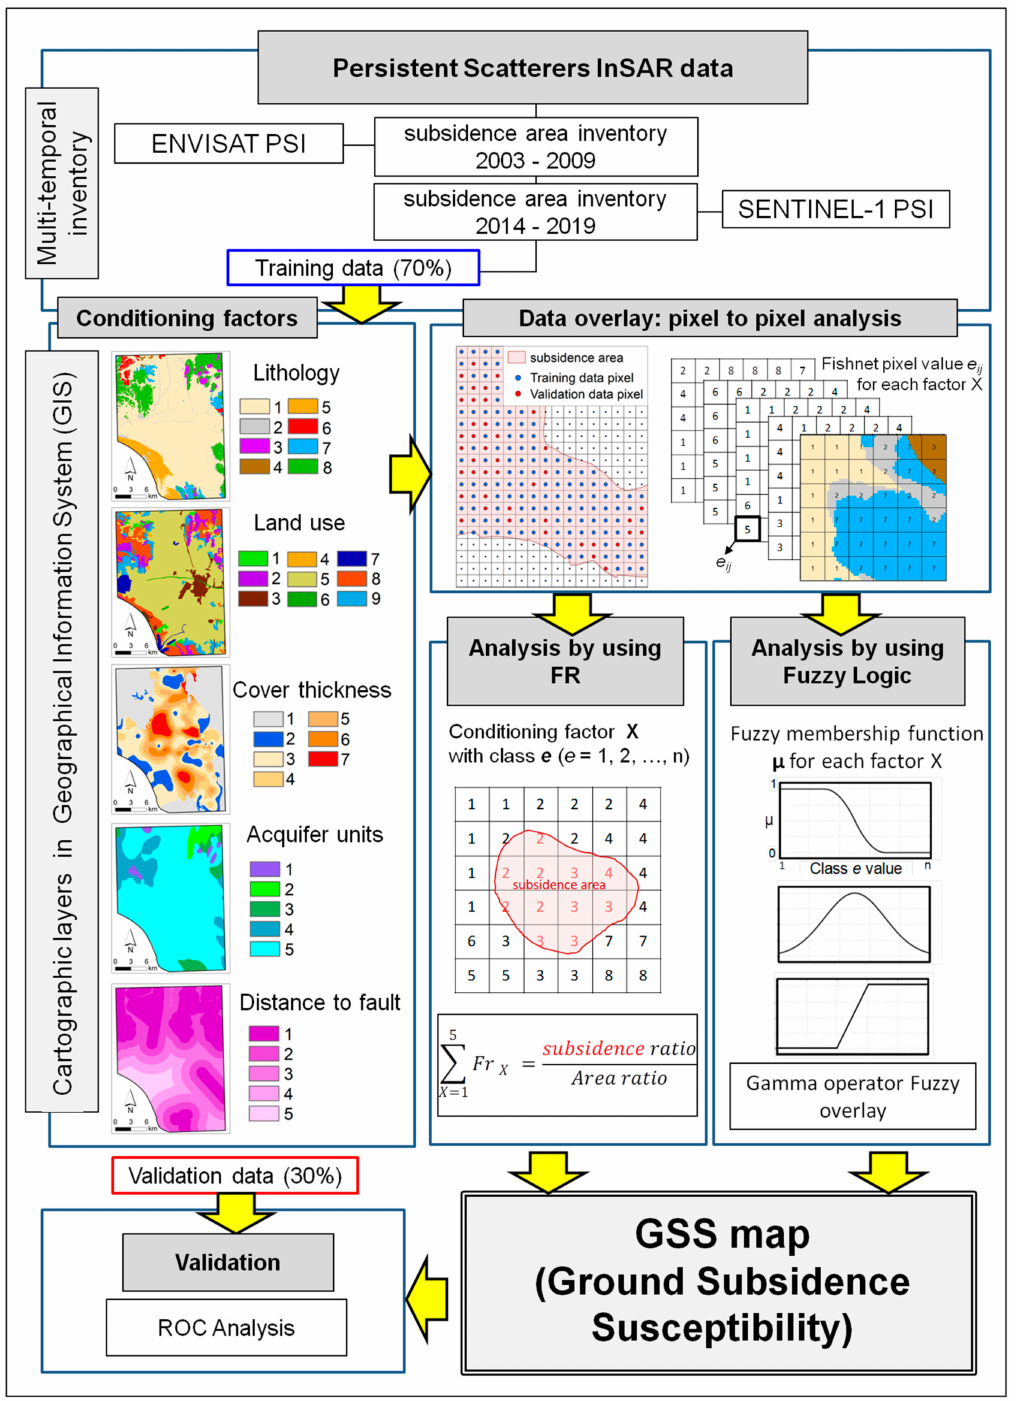
Figure 2. Methodological flowchart of the work to derive GSS map of the study area. For graphic reasons, legends of conditioning factors are included hereafter: lithology: (1) alluvial; (2) colluvial, landfill; (3) cavernous limestones; (4) marls, shales; (5) sand, silt: (6) conglomerates; (7) limestones, cherts; (8) sandstones, quartzites. Land use: (1) pasture; (2) scrubs; (3) urban; (4) semi-natural / natural; (5) crops; (6) bare soil, dunes; (7) water, river; (8) vegetation; (9) olive grove, vineyard, orchard. Cover thickness: (1) no data; (2) uncovered; (3) 10 m < ; (4) 10–20 m; (5) 20–35 m; (6) 35–50 m; (7) > 50 m. Aquifer unit: (1) impermeable rock complex; (2) crystalline rock complex; (3) calcareous rock complex; (4) sand complex; (5) basin fill alluvial complex. Distance to fault: (1) 0–1 km; (2) 1–2.5 km; (3) 2.5–4 km; (4) 4–6 km; (5) 6–10